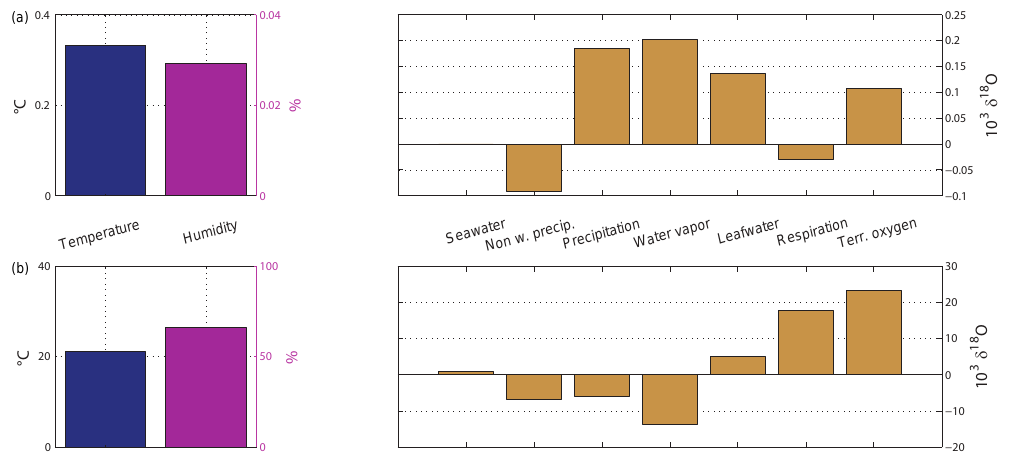
Figure 8. Evolution of the main simulated factors controlling atmospheric δ 18 O. Note that all variables are oxygen-production-weighted, i.e., integrated over vegetated areas, if not stated with “non w.”. (a) Left panel: HS_exp – LGM_ctrl anomalies of temperature and relative humidity. Right panel: (left to right) HS_exp – LGM_ctrl anomalies of seawater δ 18 O, amount-weighted precipitation δ 18 O, precipitation δ 18 O ( δ 18 O p ), water vapor δ 18 O, leaf water δ 18 O ( δ 18 O lw ), respiratory isotope fractionation ( − 18 (cid:15) resp ) and terrestrial contribution